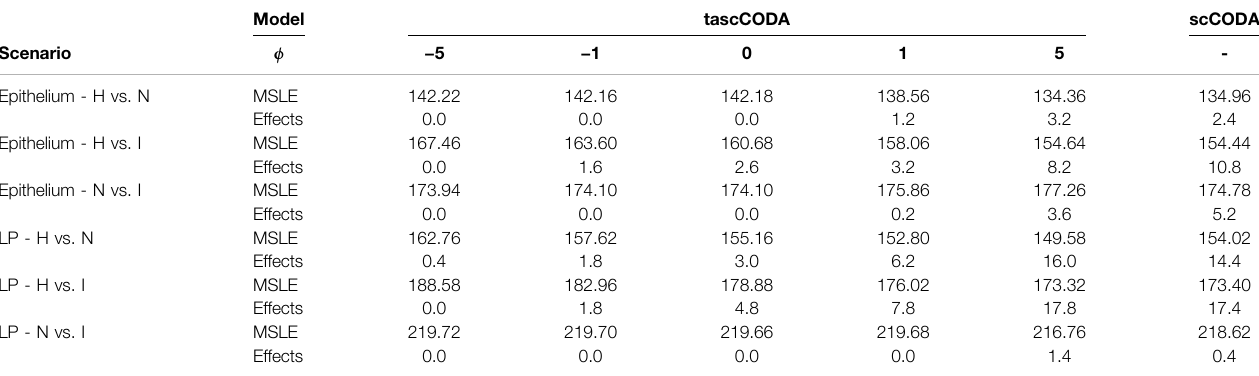
TABLE 1 | Mean squared logarithmic error (MSLE) and number of selected effects over fi ve cross-validation splits for tascCODA with different parametrizations ϕ and scCODA. Abbreviations for scenarios: Healthy (H), Non-in fl amed (N), and In fl amed (I). With increasing ϕ , tascCODA selects more effects and on average improves